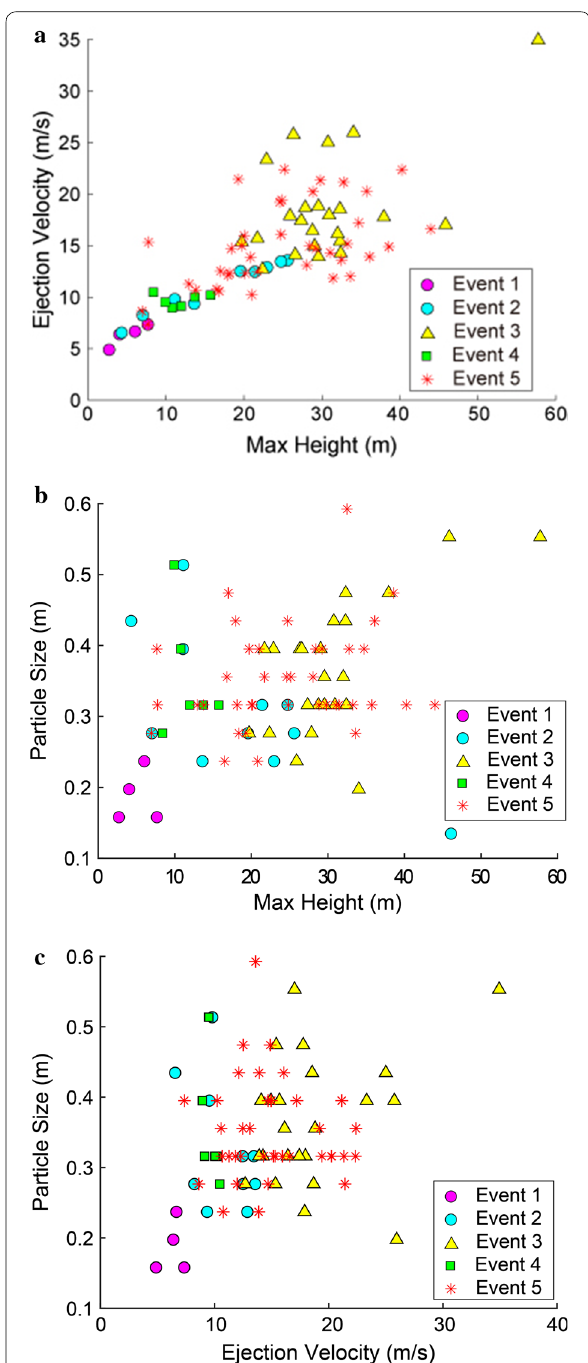
Fig. 7 Correlation plots between the characteristic parameters obtained for each trajectory. a The maximum height and the vertical ejection velocity. b The maximum height and the particle size. c The ejection velocity and the particle